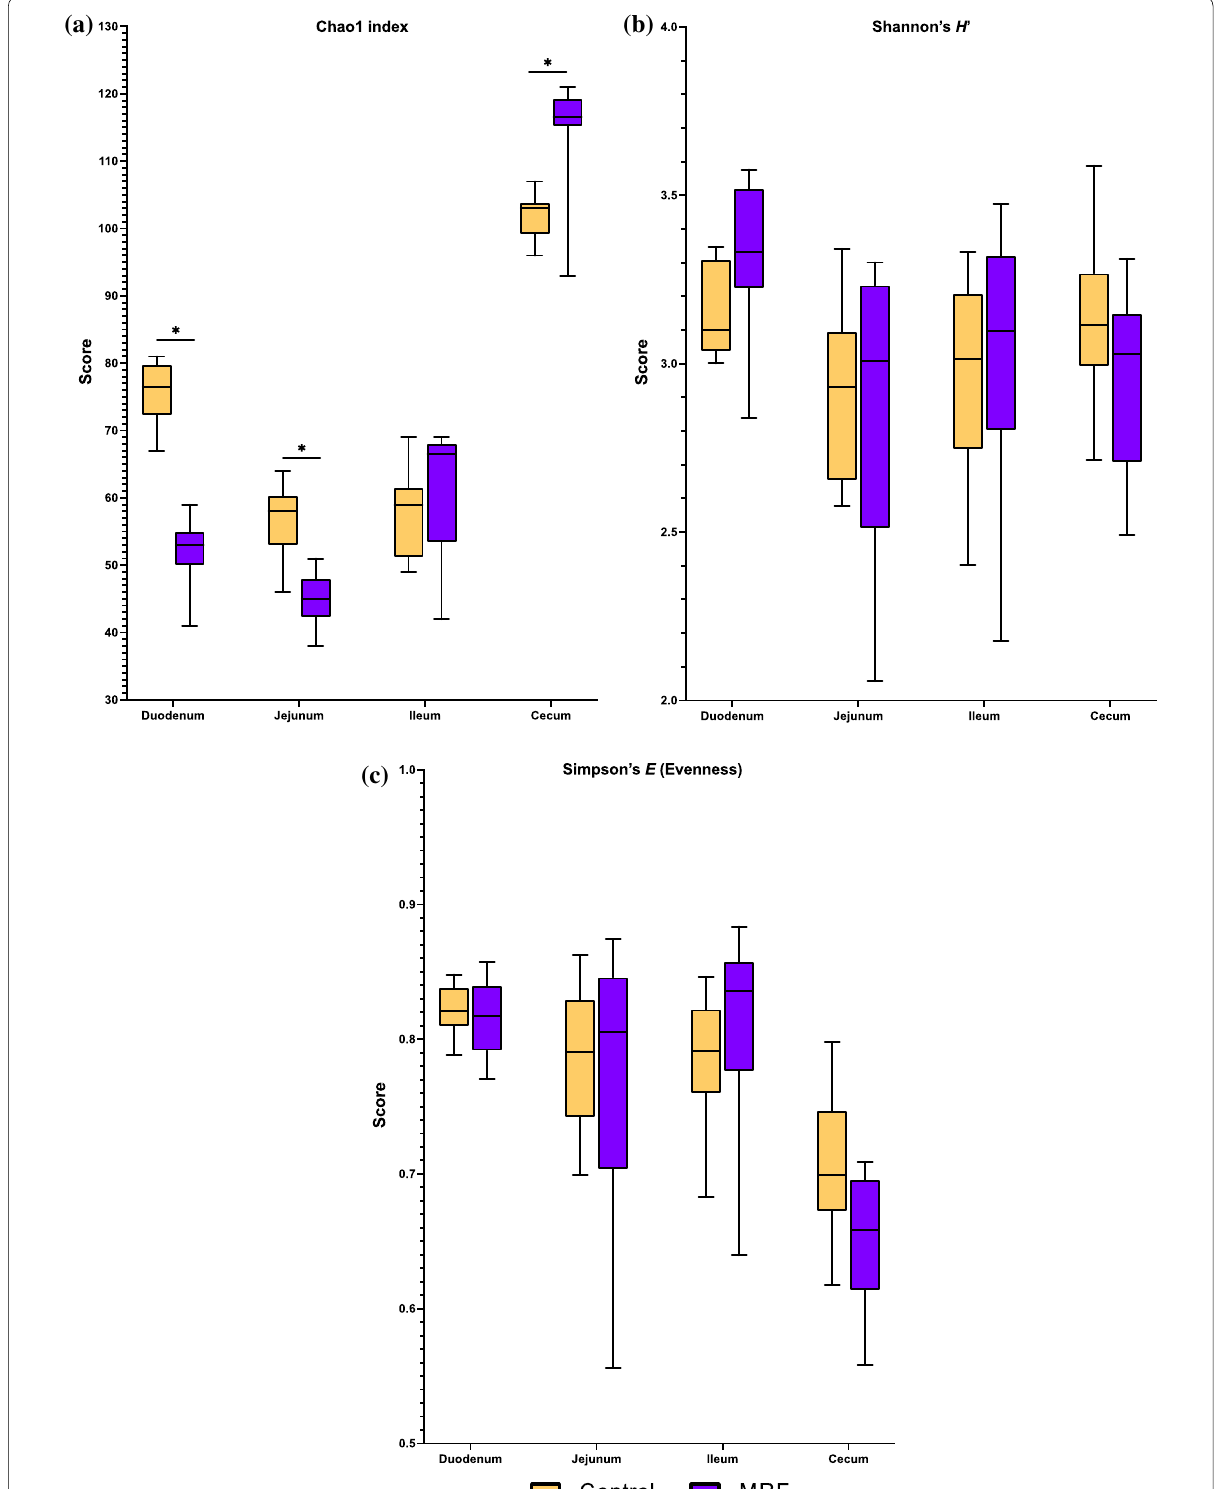
Fig. 1 a – c Four α-diversity metrics displayed for the four anatomical sites explored in this study. Statistically significant ( P BD highlighted with an